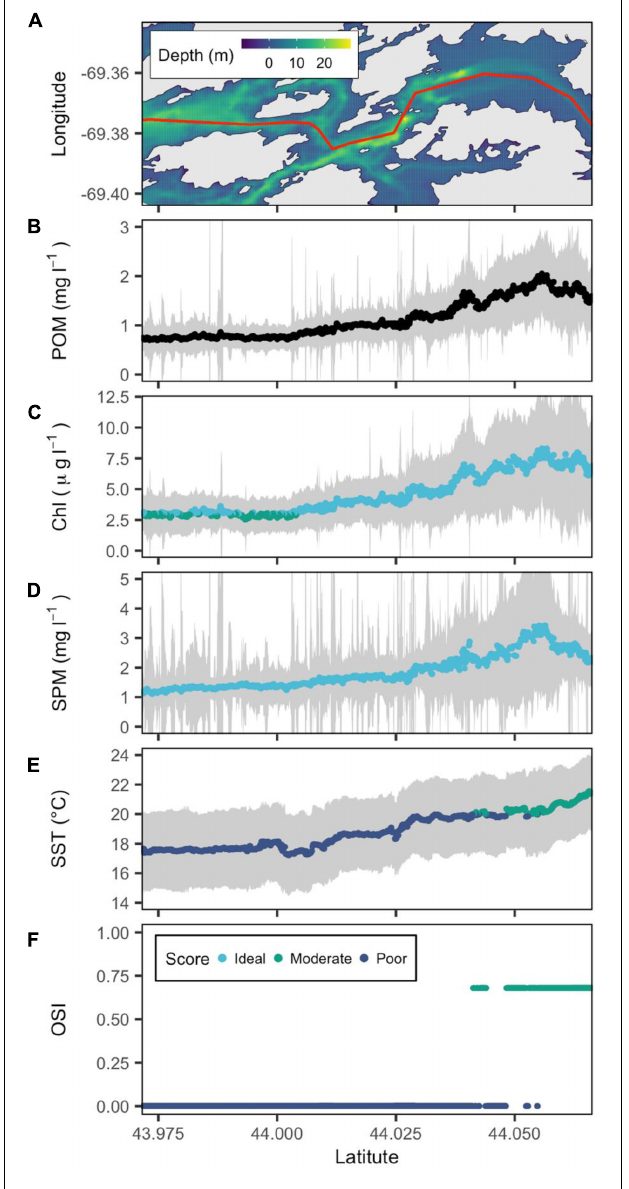
FIGURE 5 | Bathymetric map of the Medomak River estuary (from downstream to upstream left to right) with a red line showing the central transect. (A) POM (B) , SPM (C) , Chl a (D) , and SST (E) are reconstructed from remote sensing data, and OSI (F) is derived following the method of Snyder et al. (2017). Gray color belts show standard deviation of POM, SPM, Chl a, and SST derived in summer (June–September) over the period 2016–2020, with their median values depicted by blue, green, and cyan points that denote poor, moderate and ideal conditions for oyster aquaculture, respectively.